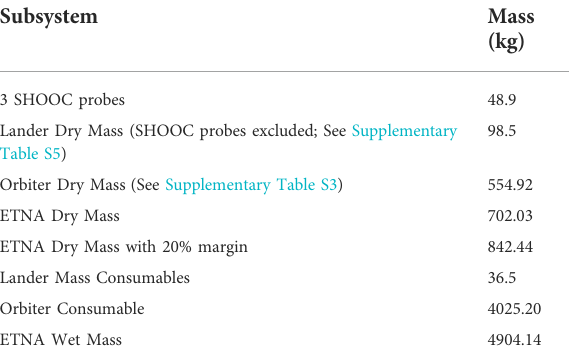
TABLE 4 Overall mission mass budget, which can be managed at launch by an SLS, Delta IV, Atlas V, or Falcon Heavy at C3 =